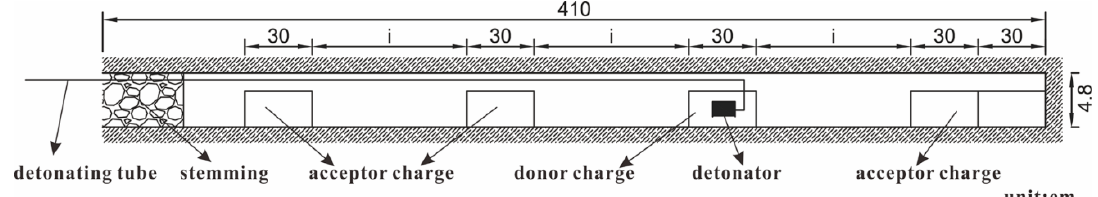
Figure 3. Schematic diagram of the charging structure used for gap distance testing.